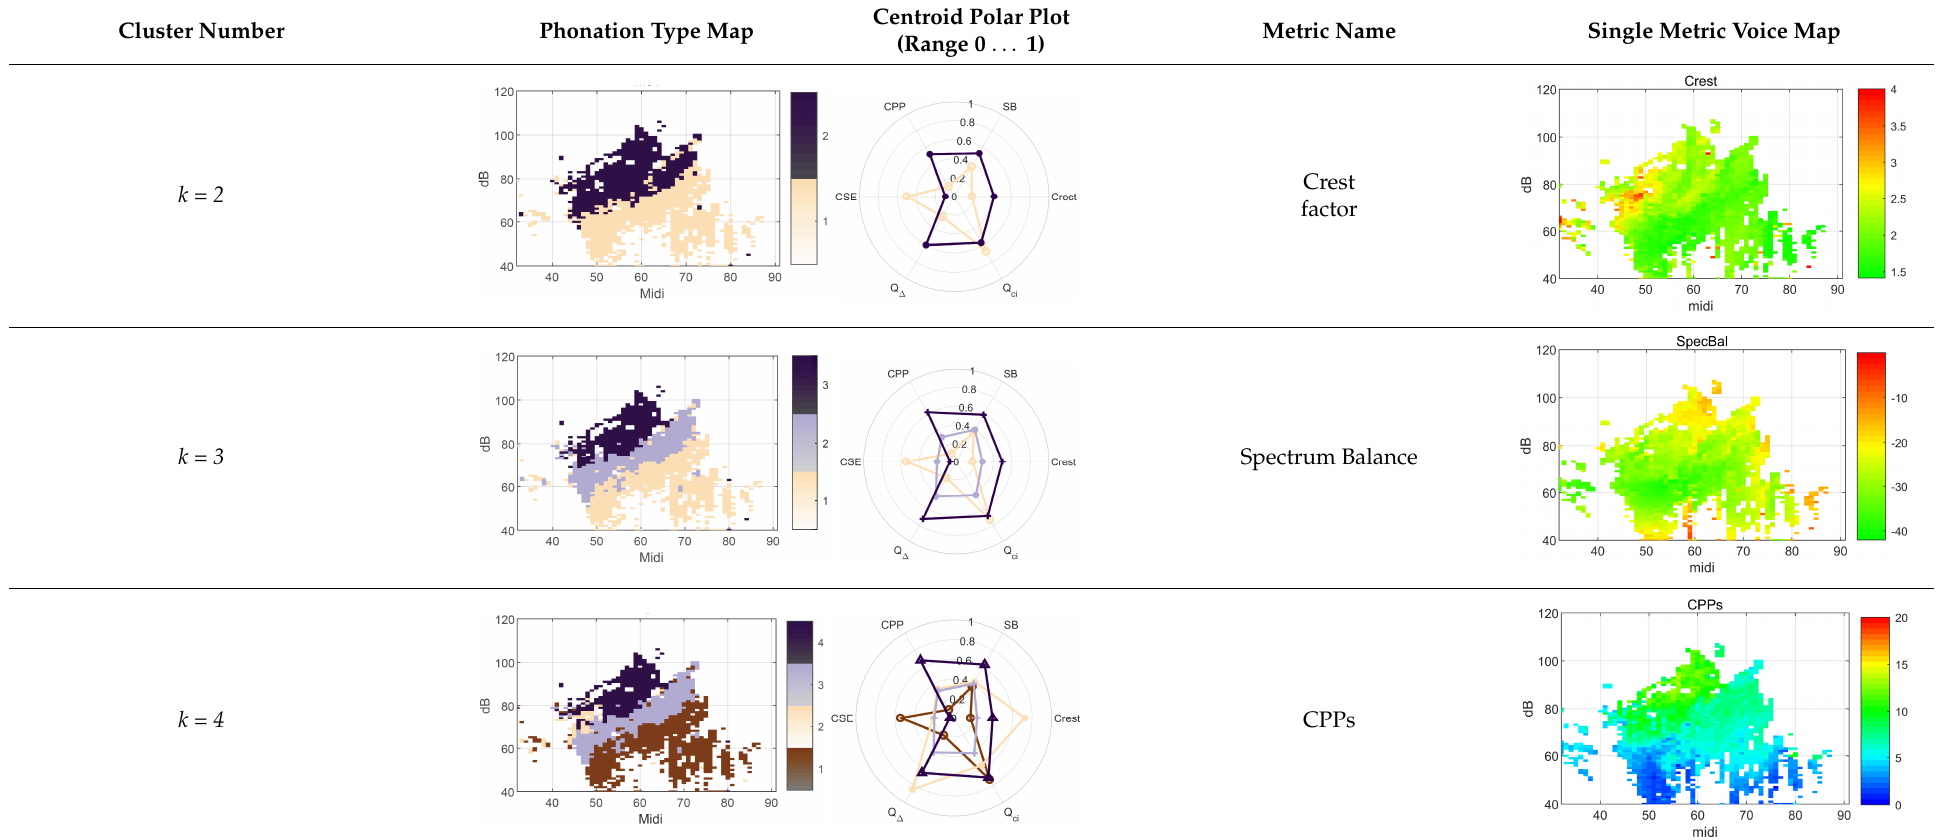
Table A1. Male participant M01.